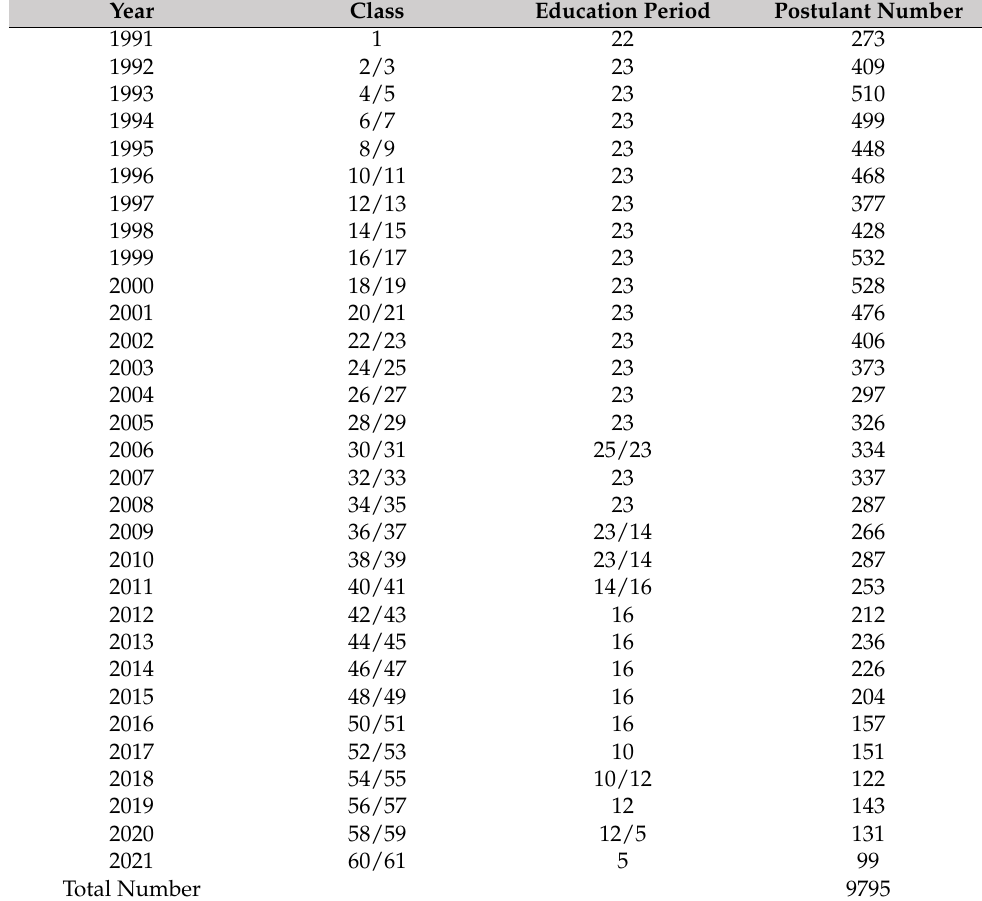
Table 1. Statistics for the Jogye Order Ordination Education over the past 30